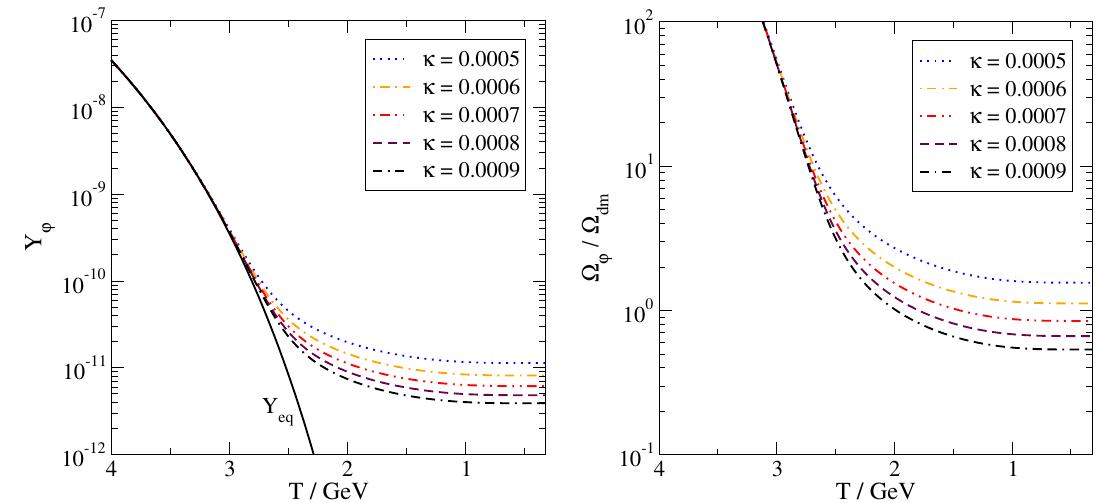
Figure 3 . Left: the solution of eq. (4.2) for a few values of κ , keeping the scalar singlet mass fixed at m ' 60 GeV. Right: the same for the fractional contribution of ϕ to the dark matter energy ϕ density. The hadronic error bands from figure 2 are much narrower than the line widths, given that hadronic effects are much suppressed compared with the 2 ↔ 1 process when T = (1 – 3)